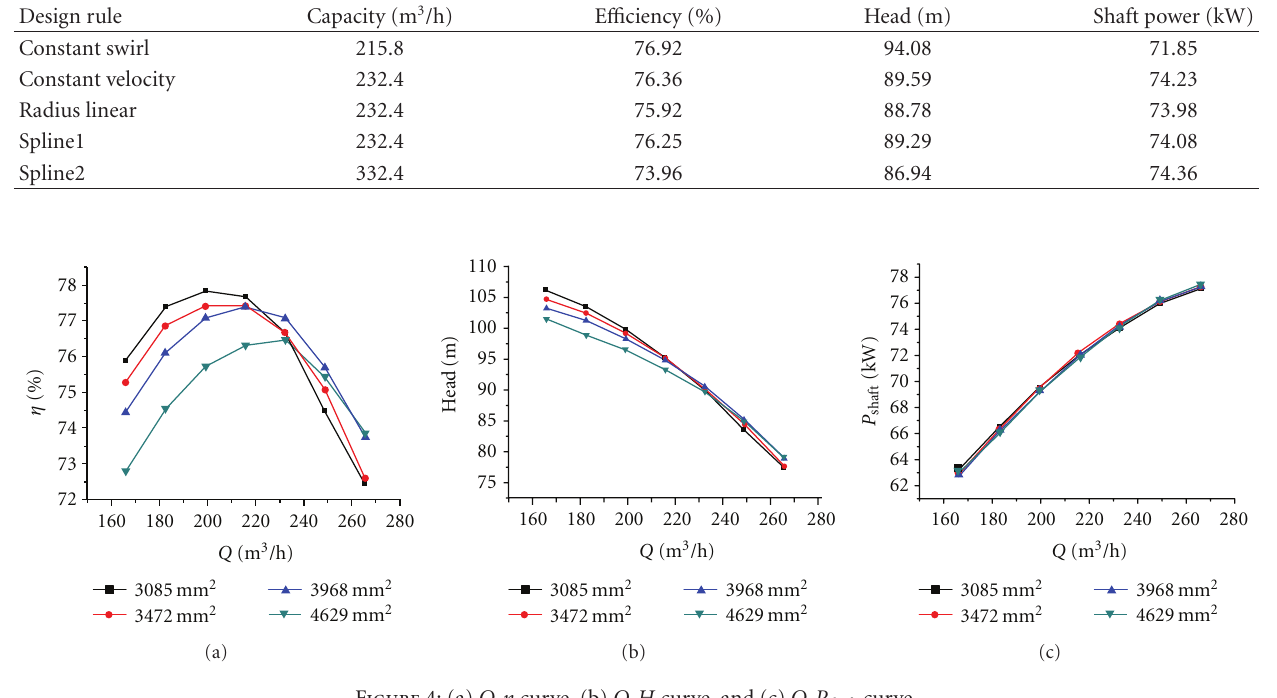
Table 4: List of pump BEPs with di ff erent volute design rules.